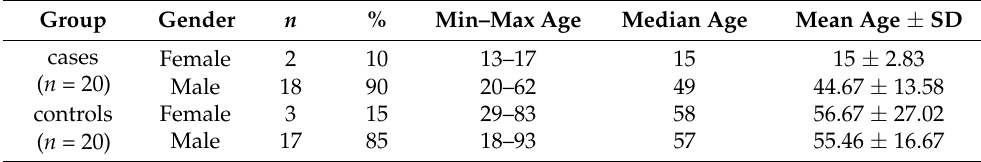
Table 4. Demographic characteristic of the patients’ groups enrolled in the